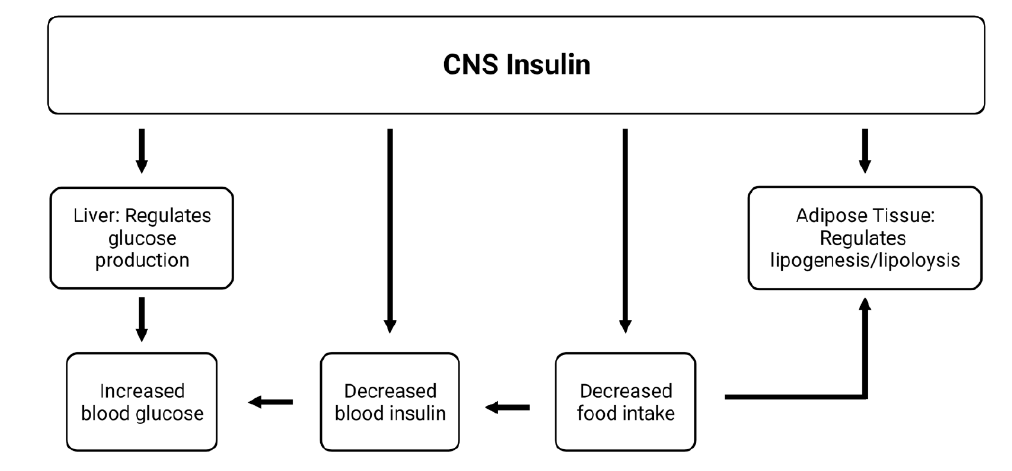
Figure 4. Influence of CNS insulin on the periphery. CNS insulin has been shown to have many impacts on peripheral metabolism including increasing blood glucose, decreasing blood insulin, and decreasing food intake. Some of these impacts may be regulated by the sympathetic effect of insulin on liver glucose production and/or adipose tissue regulation of lipogenesis and lipolysis. Many of these influences impact insulin BBB transport, such as serum triglyceride and insulin level, which ultimately affects CNS insulin